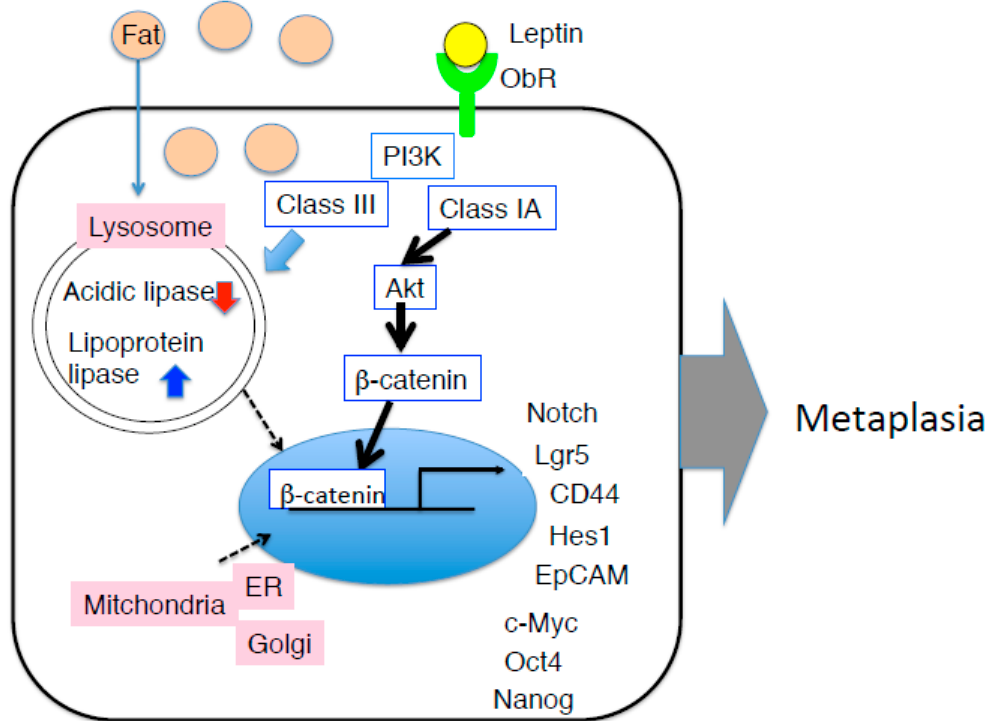
Figure 3. Hypothesis mechanism of intestinal metaplasia of the gastric mucosa in HFD-induced obese mice. In addition to JAK-STAT pathway, by PI3K-Akt- β -catenin pathway may be strongly induce pluripotent gene, leading to the onset of intestinal metaplasia. Amount of HFD causes lipotoxic